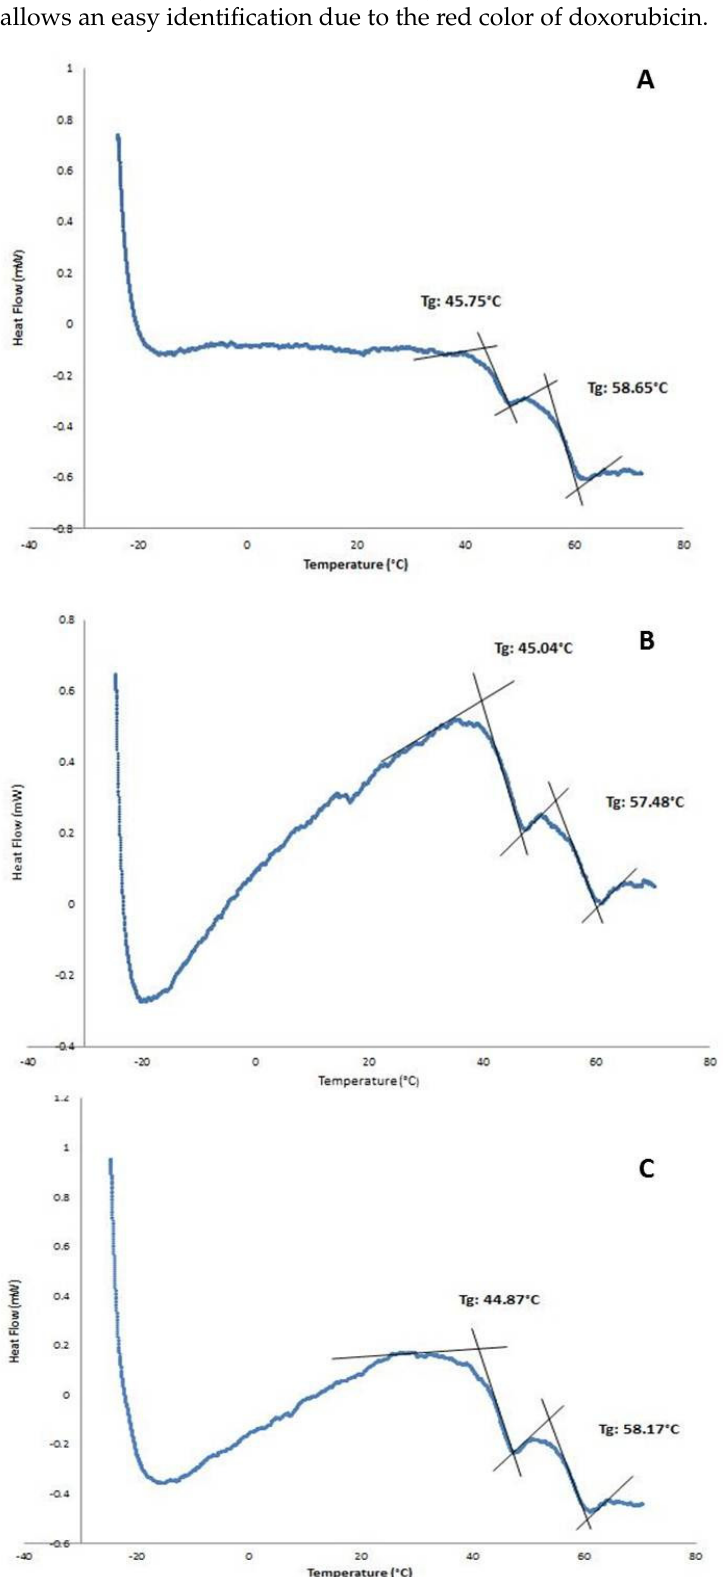
Figure 3. DSC thermograms of PLLA/PLGA DWNPs with mass ratios: ( A ) 2:1, ( B ) 4:1, ( C ) 6:1.